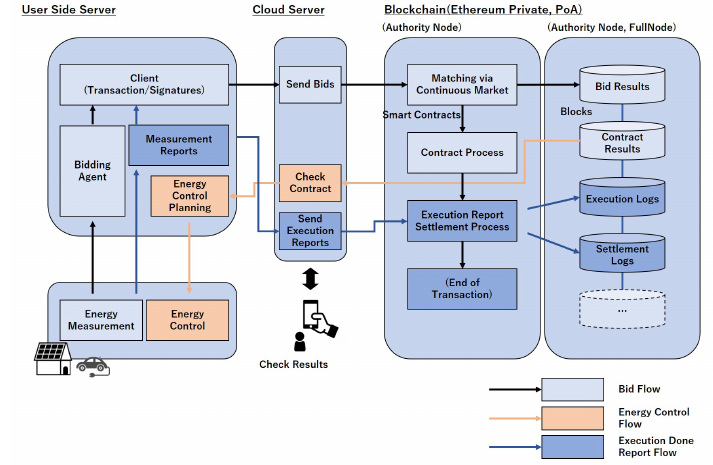
Figure 1. overall architecture.